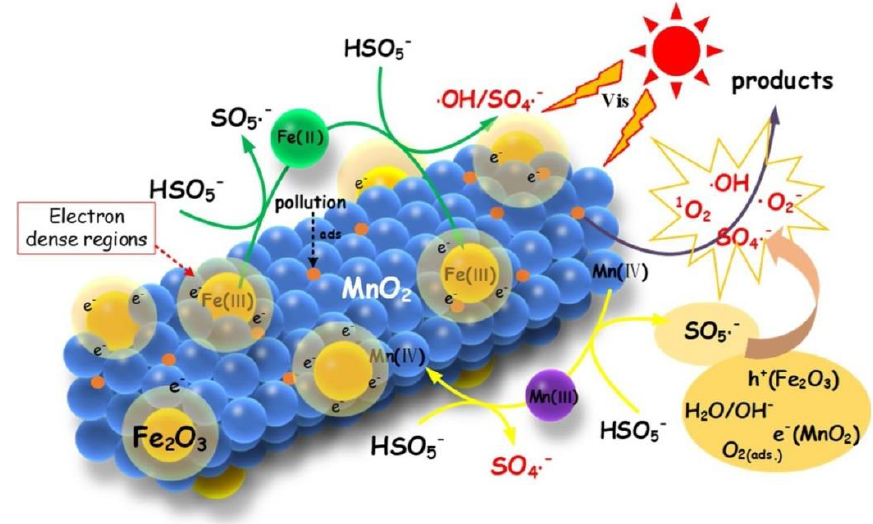
Figure 2. The reaction mechanism for the removal of organic pollutants in the nanohybrid MnO 2 incorporating a Fe 2 O 3 /PMS/Vis system. Reprinted with permission from ref. [19]. Copyright 2020 Elsevier B.V.